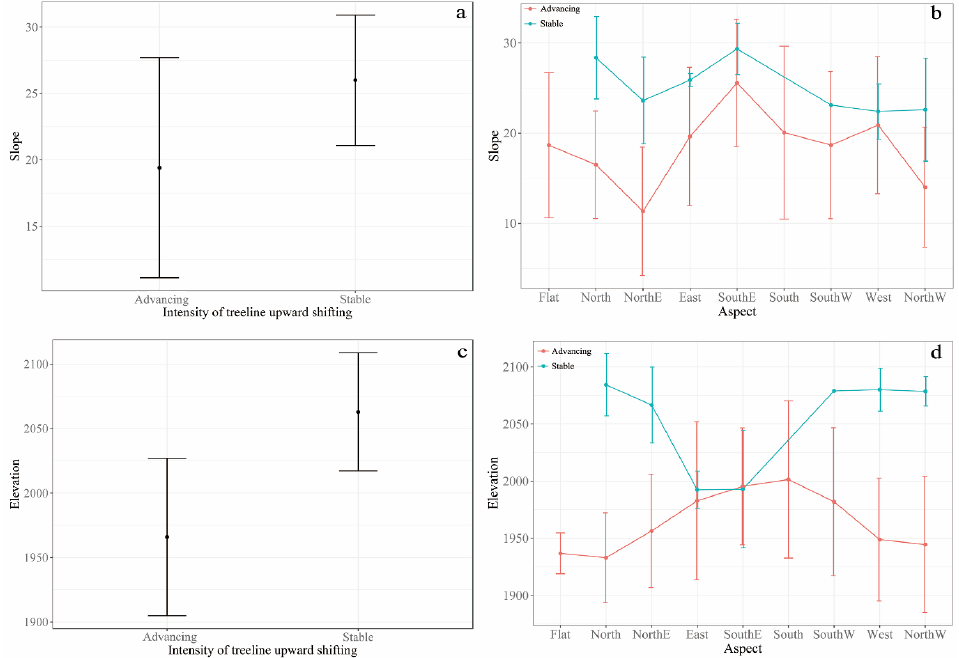
Figure 11. Topographic effects on local variations of upward tree line shift. ( a ) Error bars of slope for advancing and stable tree lines; ( b ) error bars for slope in aspect for advancing and stable tree lines; ( c ) error bars for elevation of advancing and stable tree lines; ( d ) error bars of elevation for different aspects of advancing and stable tree lines.